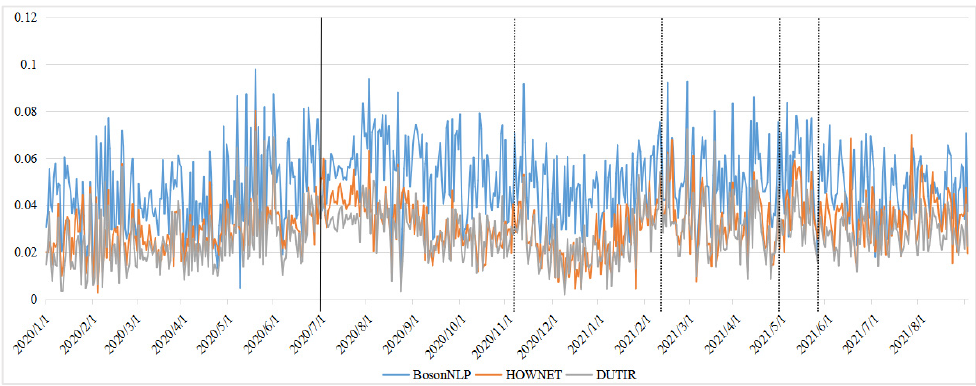
Figure 6. Trend of daily sentiment scores obtained by each method. Table 13. Sentiment intensity of positive and negative comments before and after the implementation of industry normative policies for live